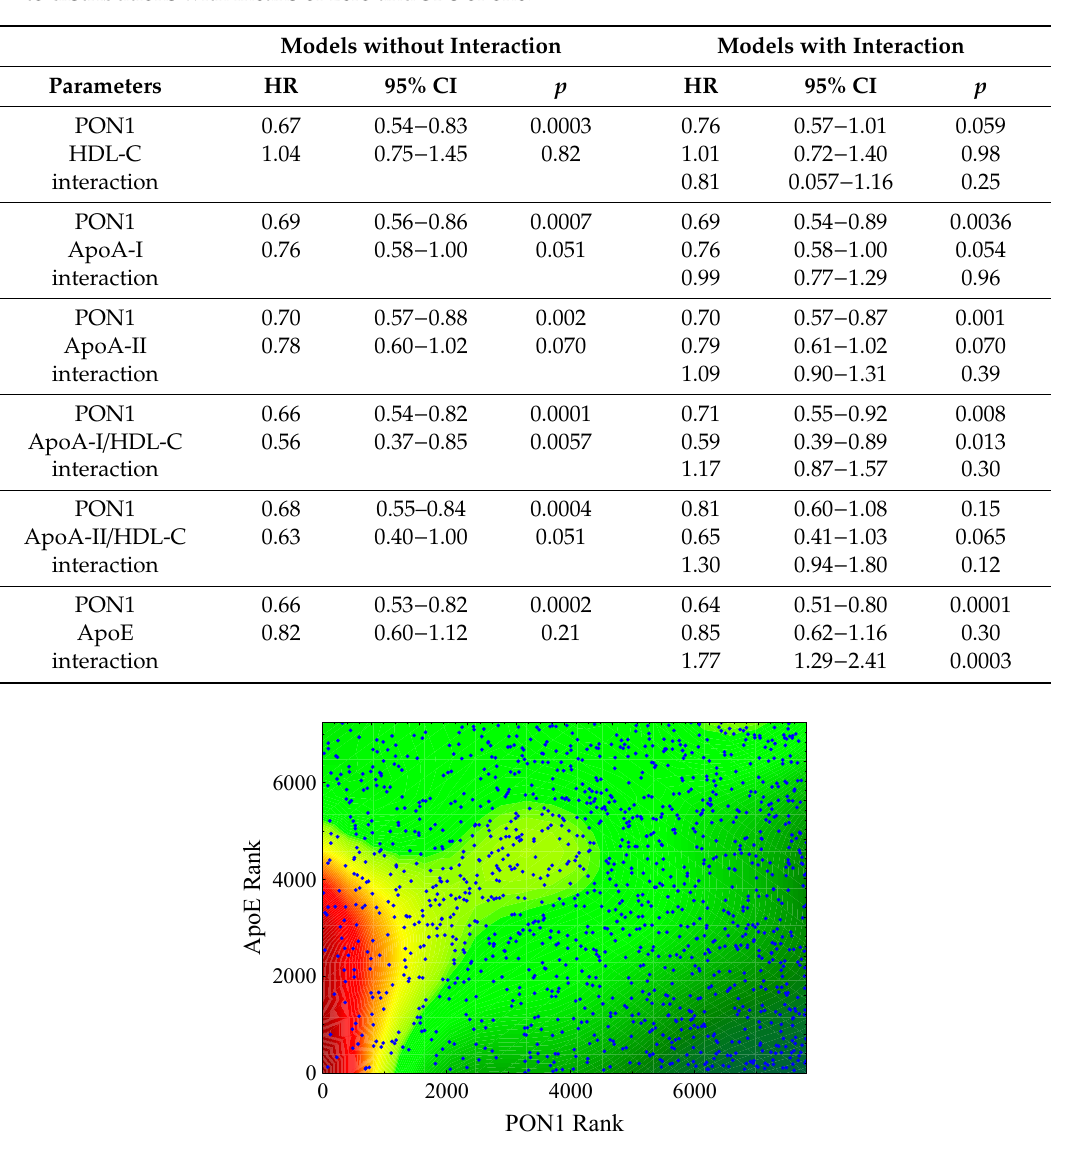
Figure 2. Contour plot of the estimated cardiac event rate as a function of PON1 rank and apoE rank in the high HDL/high CRP population (HR2).